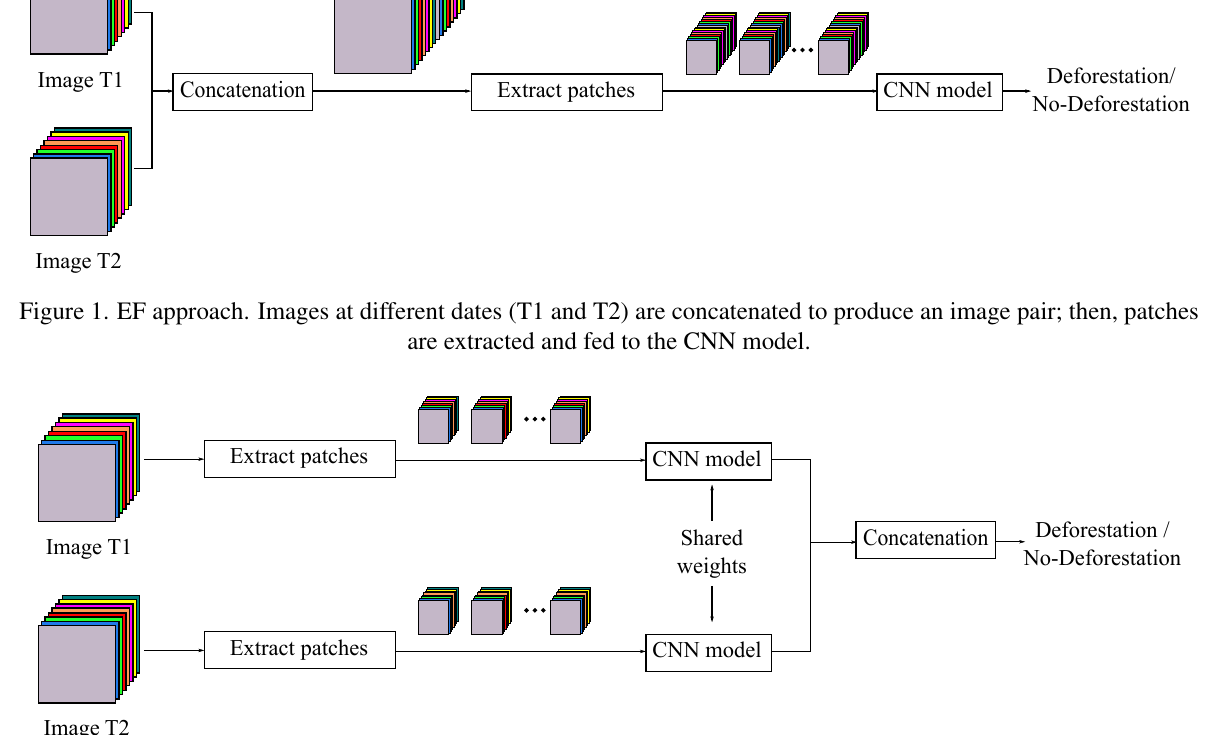
Figure 2. Siamese network. Patches of each image (T1 and T2) are extracted and fed to the CNN model independently. The two branches in the network share exactly the same architecture and parameter values.